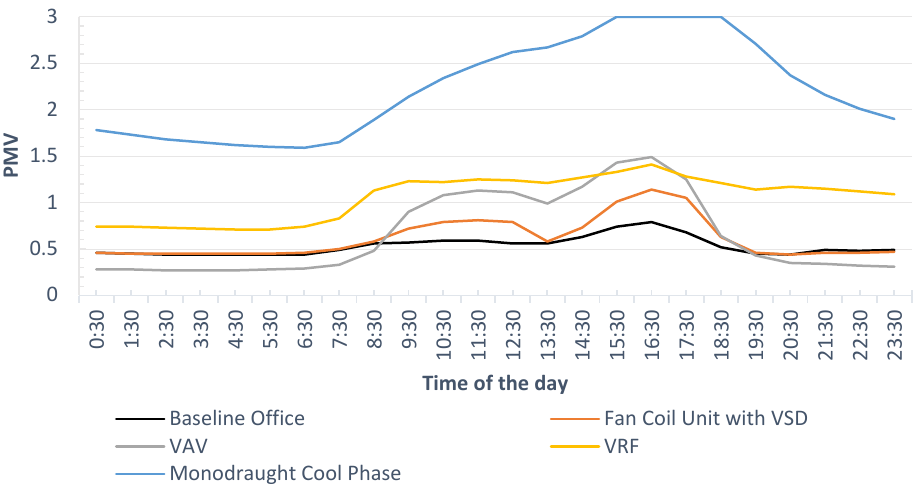
Figure 8. Trend in PMV for different cooling systems on 17th July.